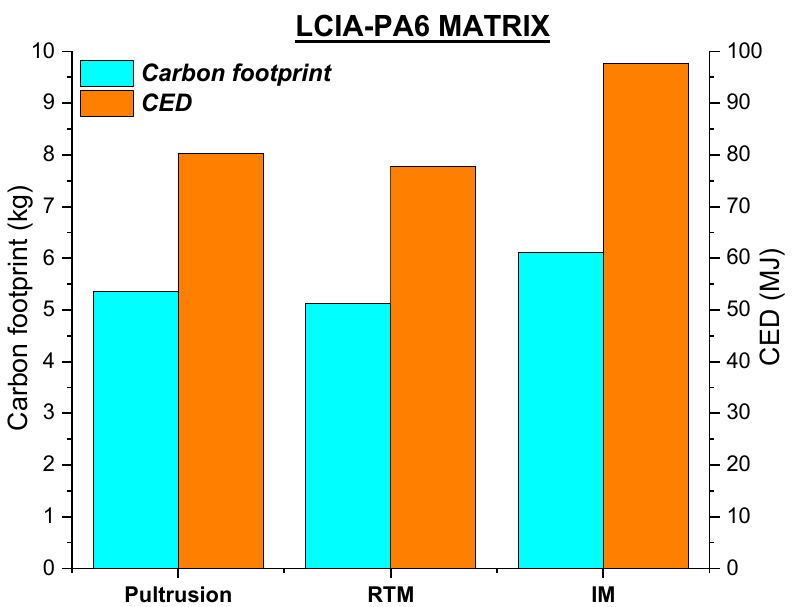
Figure 18. LCIA results related to three composite manufacturing processes: pultrusion, injection molding (IM), and resin transfer molding (RTM). The carbon footprint is indicated on the left ordinate, and the cumulative energy demand (CED) is on the right ordinate.